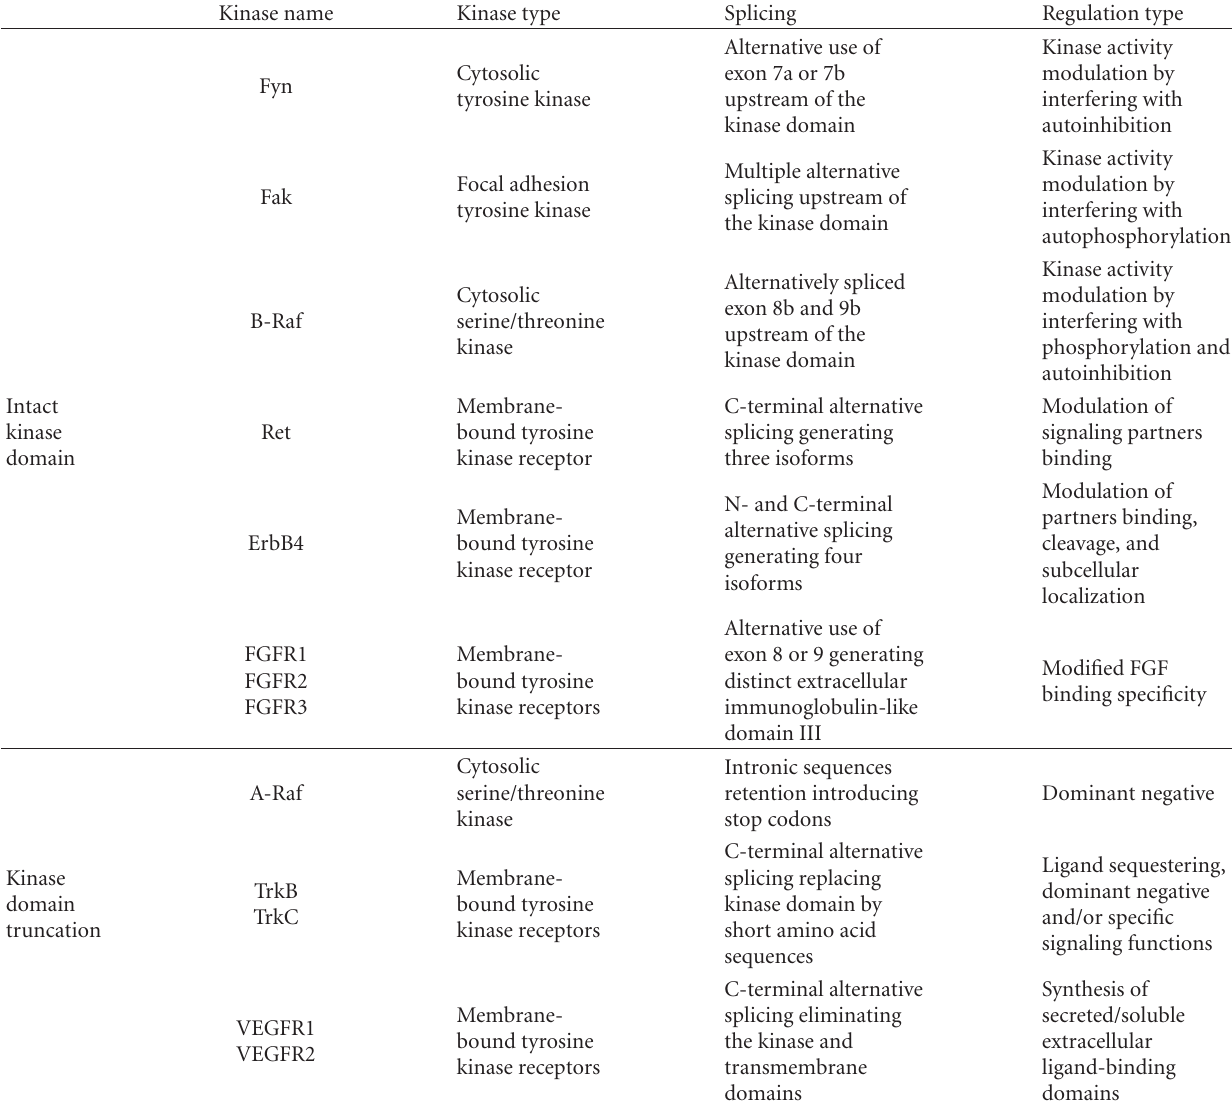
Table 1: Regulatory mechanisms of oncogenic kinases activity by alternative